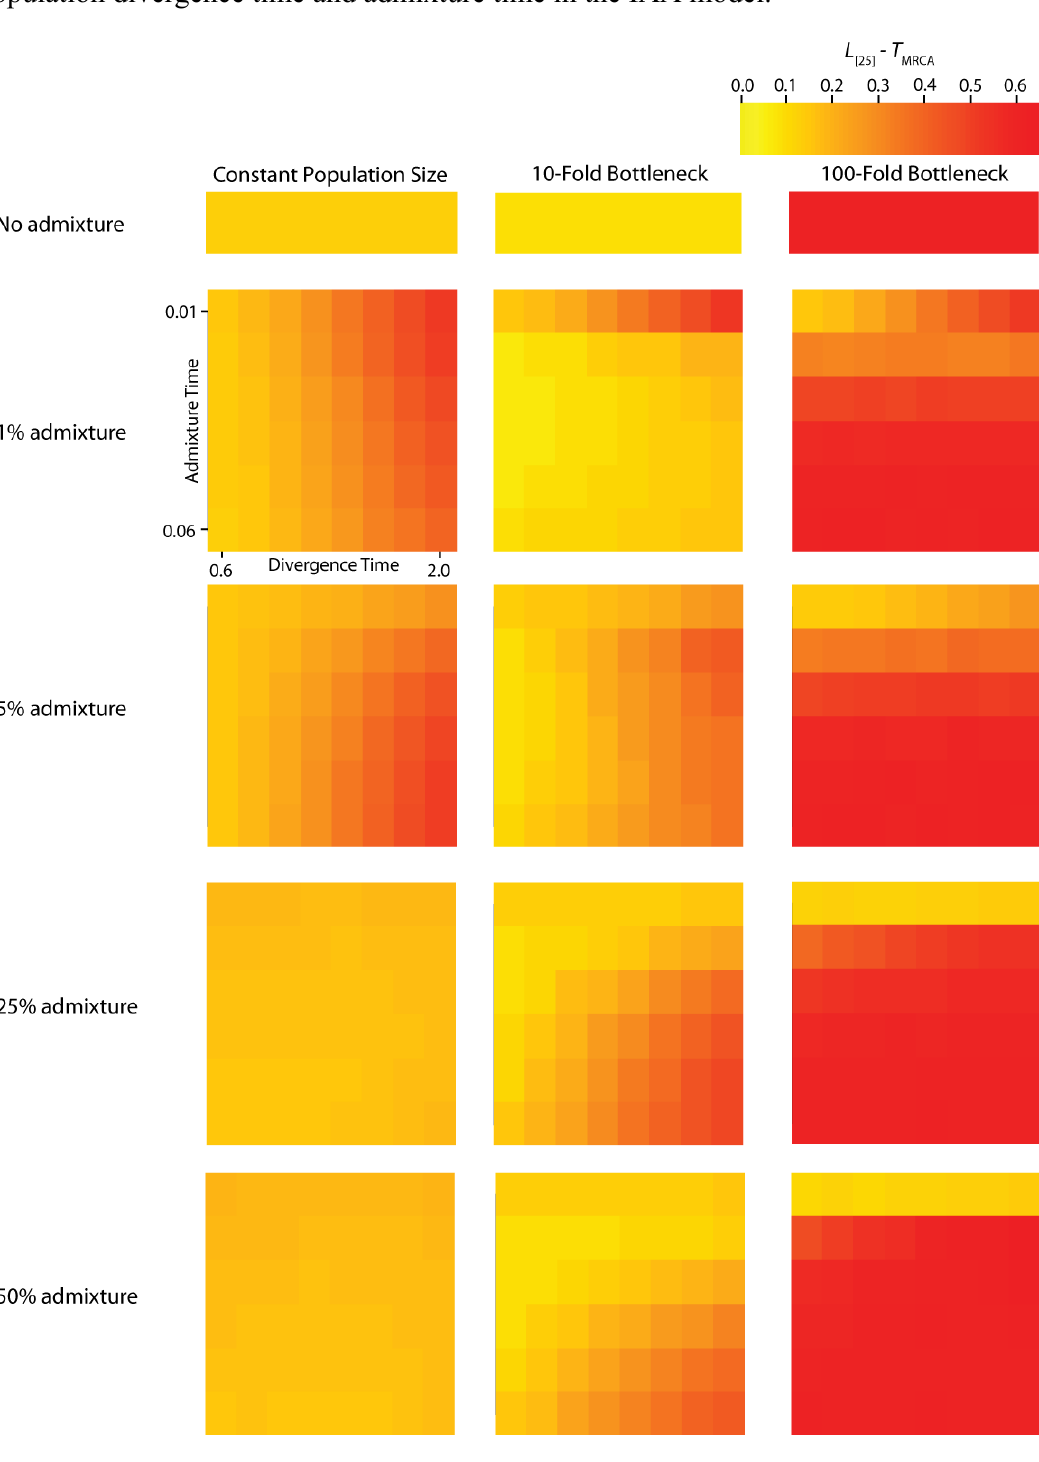
Figure 6. Simulated autocorrelation coefficients for T at a lag of 25 gene trees. Each MRCA column corresponds to a different magnitude of founder event in the colonizing population. Each row represents differing levels of admixture between the colonizing and endemic populations. Finally, within each panel, squares correspond to different combinations of population divergence time and admixture time in the IAA